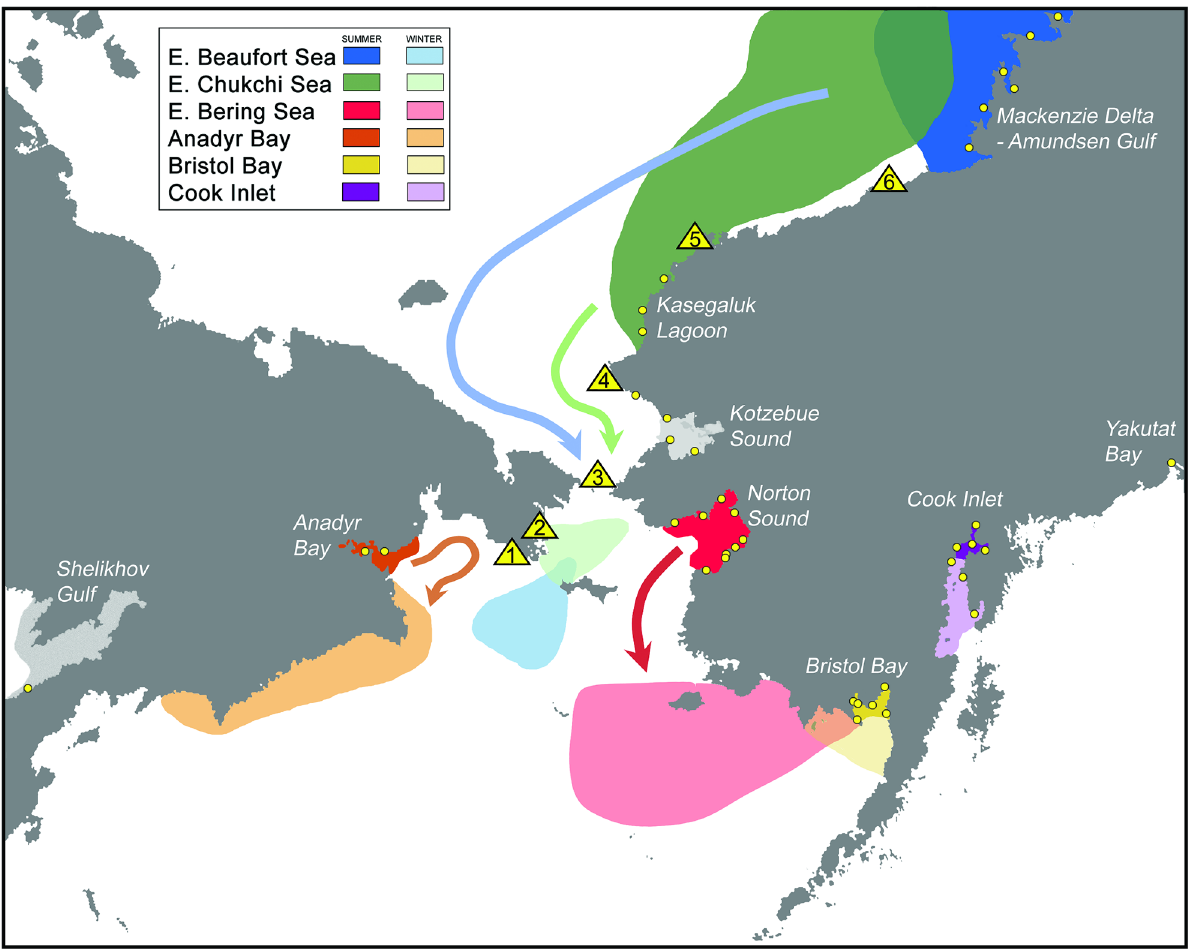
Fig 2. Migration routes and sampling locations of beluga whales from the major summer concentration areas in the Bering, Chukchi and Beaufort Seas and from the Gulf of Alaska. Summering and wintering areas, and migration routes were inferred from a combination of satellite telemetry, aerial and shore based sightings, and Traditional Ecological Knowledge (TEK). Sampling sites are indicated by yellow circles and in the case of migration by